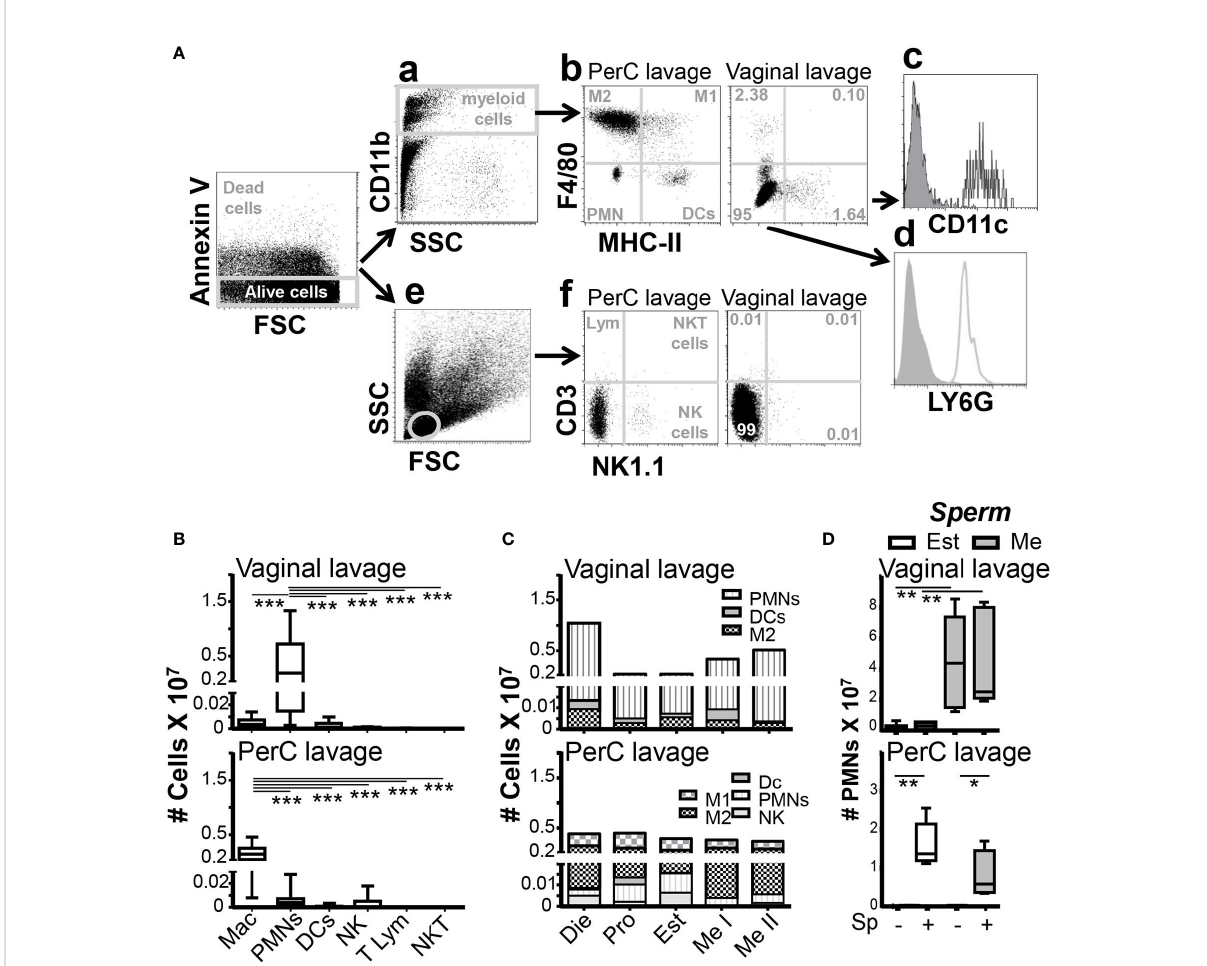
FIGURE 1 Vaginal lumen immune cells analysis by Flow cytometry. (A) Flow cytometry gating strategy. Myeloid analysis: a : Dot plot shows a gating region (R1) that identi fi es myeloid cells based on CD11b positivity and high SSC characteristics. b : Plot shows a gate based on f4/80 and MHC-II to sort M1, M2, PMN and DCs. Those populations were further characterized by the markers Ly6G, Ly6C, CD11c, CCR2 ( c and d ). Lymphoid analysis: e: Dot plot shows a gating region (R2) that identi fi es lymphoid cells based on SSC and FSC characteristics. f: Plot shows a gate based on CD3 and NK1.1 to sort lynphocites, NK and NKT cells. (B) Identi fi cation of distinct immune cells in the vaginal and peritoneal lavage from unstimulated female mice by fl ow cytometry. Data are expressed as box and whiskers 10-90 percentile (n=8 to 10 mice per group). (C) Adult female mice were selected by vaginal smear. Stacked bar chart representation of the immune cells frequency during the ovarian cycle in the peritoneal cavity and the vagina (Data from Supplemental Figure 1C). (D) Estrus and metestrus adult female mice were selected by vaginal smear and challenged in the vagina or peritoneal cavity with sperm for 2h. Data are expressed as box and whiskers 10-90 percentile (n=8 to 12 mice per group). *p < 0.05, **p < 0.01 and ***p < 0.001. Mann-Whitney test. PerC, peritoneal cavity; Mac, macrophages; M1, in fl ammatory macrophages; M2, resident macrophages; PMN, neutrophil polymorphonuclears; DC, dendritic cells; NK, natural killers; T Lym, T lymphocytes; NKT, natural killers T cells; Die, Diestrus; Pro, Proestrus; Est, Estrus; Me I, Metestrus I and Me II, Metestrus